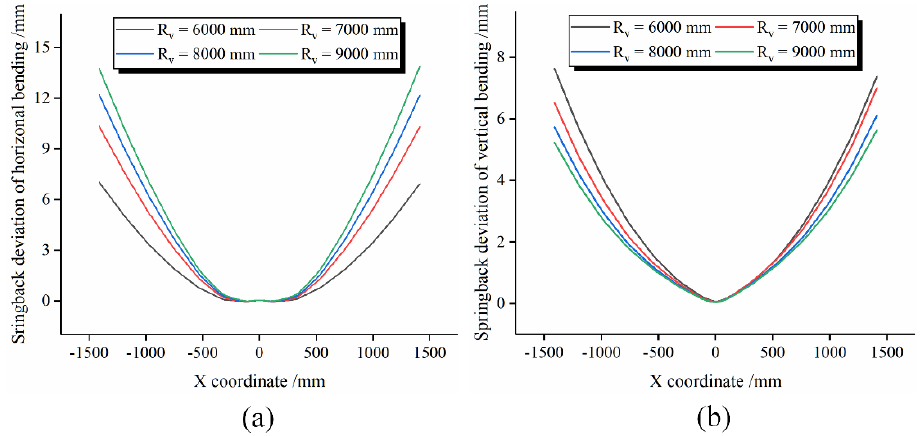
Figure 7. Springback deviation with different vertical bending radii. ( a ) Springback deviation of horizonal bending. ( b ) Springback deviation of vertical bending. horizonal bending. ( b ) Springback deviation of vertical